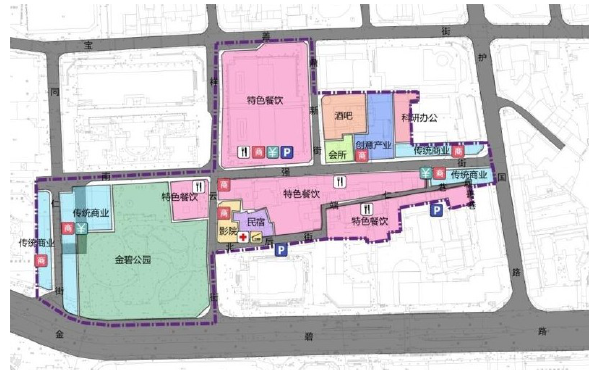
Figure 10. Typical E-Restaurant Platform in China, to